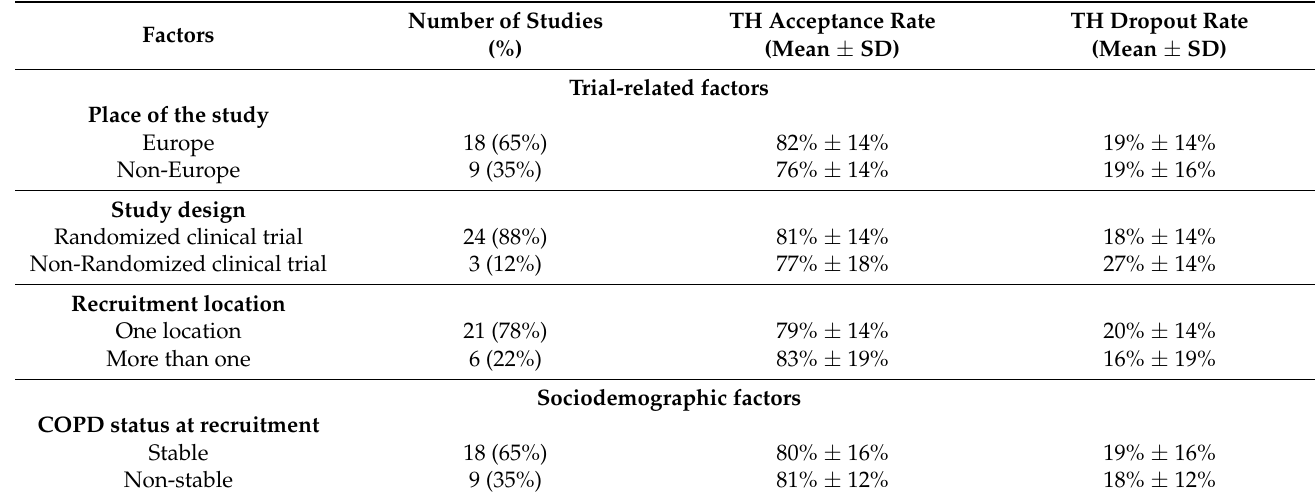
Table 1. Overall acceptance and dropout rates across included studies stratified by trial-related, sociodemographic, and intervention-related factors ( n = 27) a